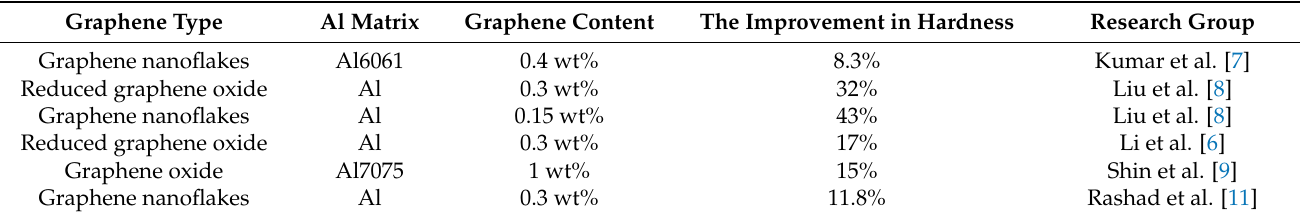
Table 1. Experimental hardness of Al–graphene composites sintered by powder